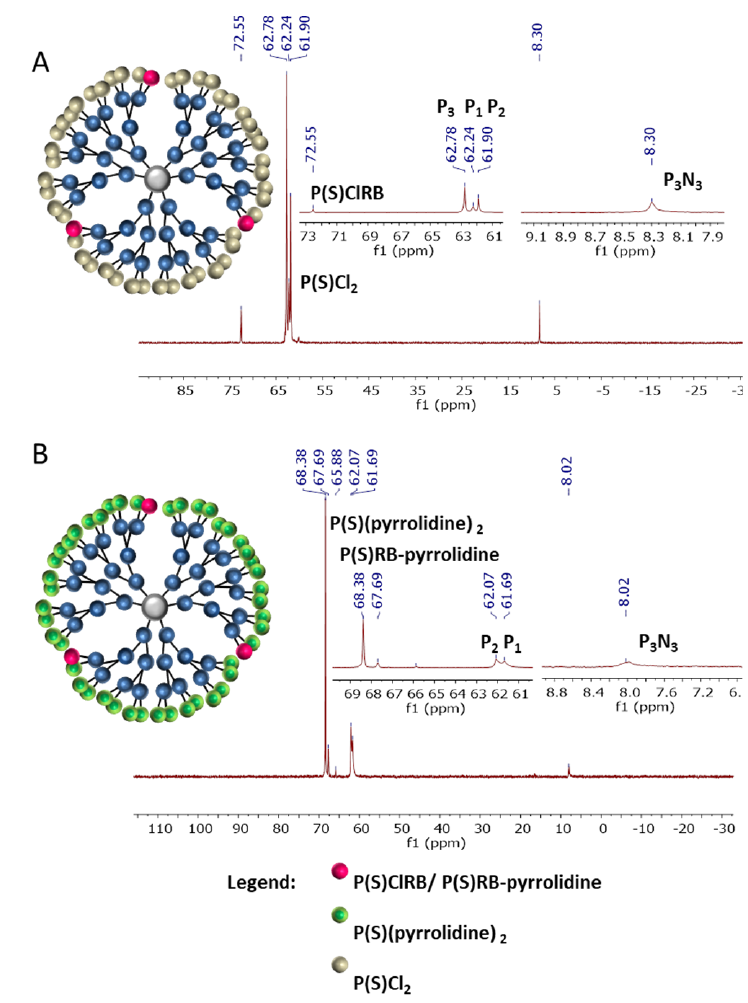
Figure 5. 31 P NMR spectra for: ( A ) G3–3RB (CDCl 3 ; ppm); ( B ) G3–3RB–45 pyrrolidine (G3-3RB-pyrro) (CDCl 3 ; ppm).